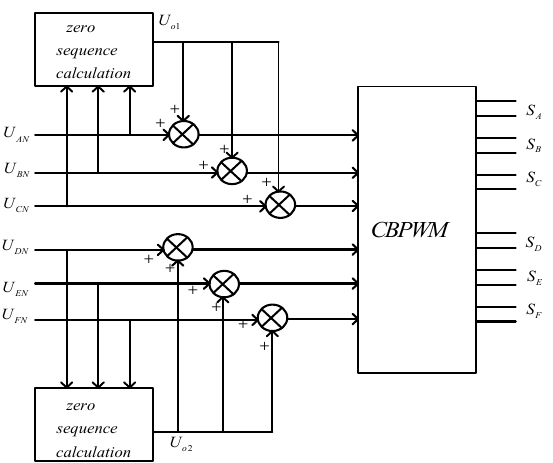
Figure 11. Double zero-sequence injection pulse width modulation (PWM) strategy.